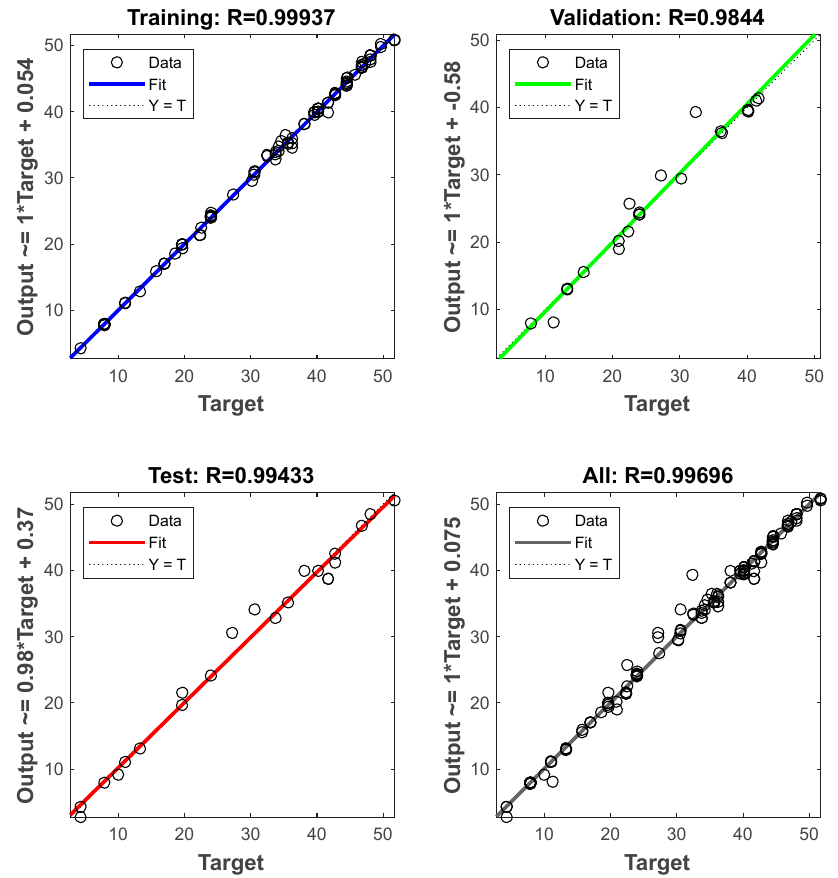
Figure 10. ANN training, validation, and testing stages with the related regression coefficient for UCS and